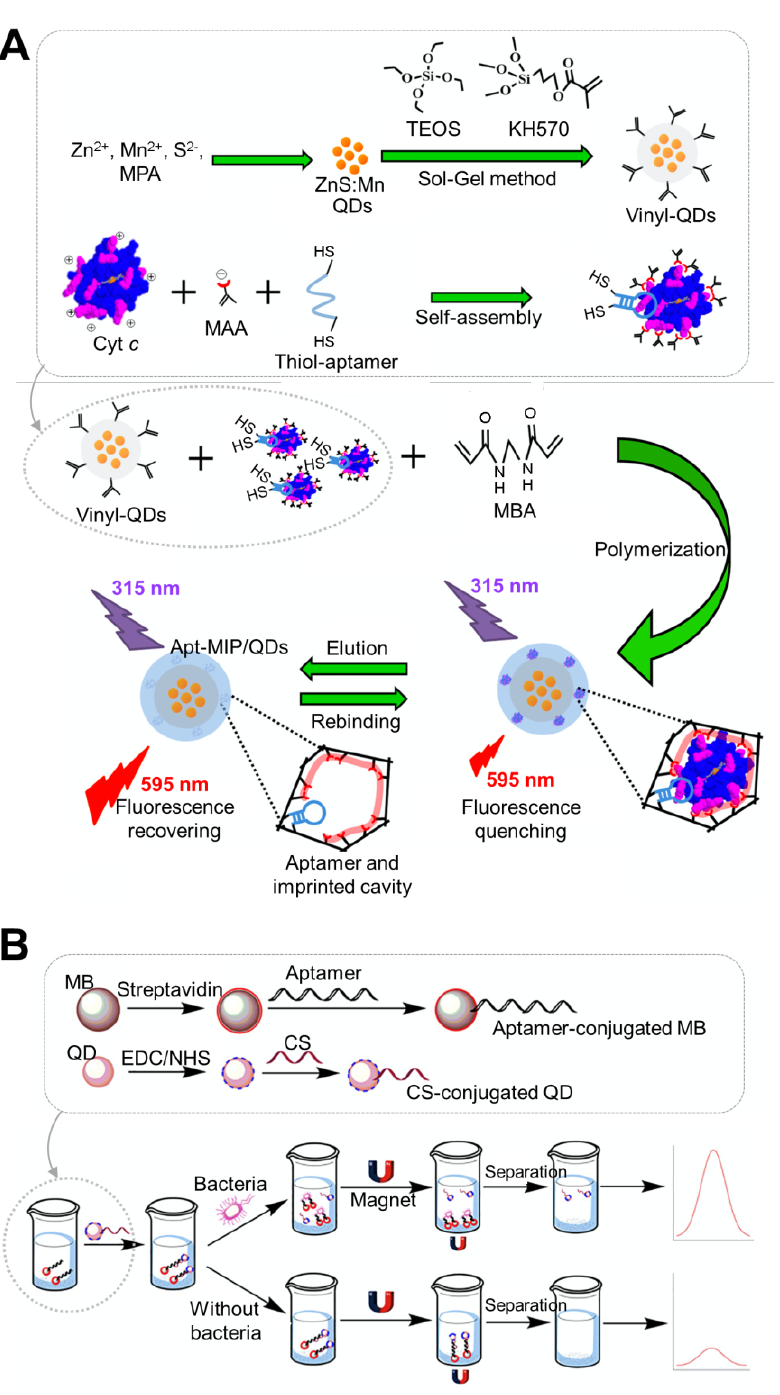
Figure 1. Quantum dot (QD) biosensing strategy based on change in optical signal of QD by aptamer-analyte binding: ( A ) Vinyl modified Mn/ZnS QD biosensor for detection of cytochrome c. Reproduced with permission from [44]; ( B ) magnetic nanoparticle-CdTe QD biosensor for detection of Salmonella typhimurium . Reproduced with permission from [46]. MPA, 3-Mercaptopropionic acid; TEOS, tetraethoxysilane; KH570, γ-methacryloxypropyl trimethoxy silane; MAA, methcrylic acid; MBA, N, N′-methylenebisacrylamine; EDC, 1-Ethyl-3-(3-dimethylaminopropyl) carbodiimide hydrochloride; NHS, N -hydroxysuccinimide; CS, complementary strand; MB, magnetic bead.